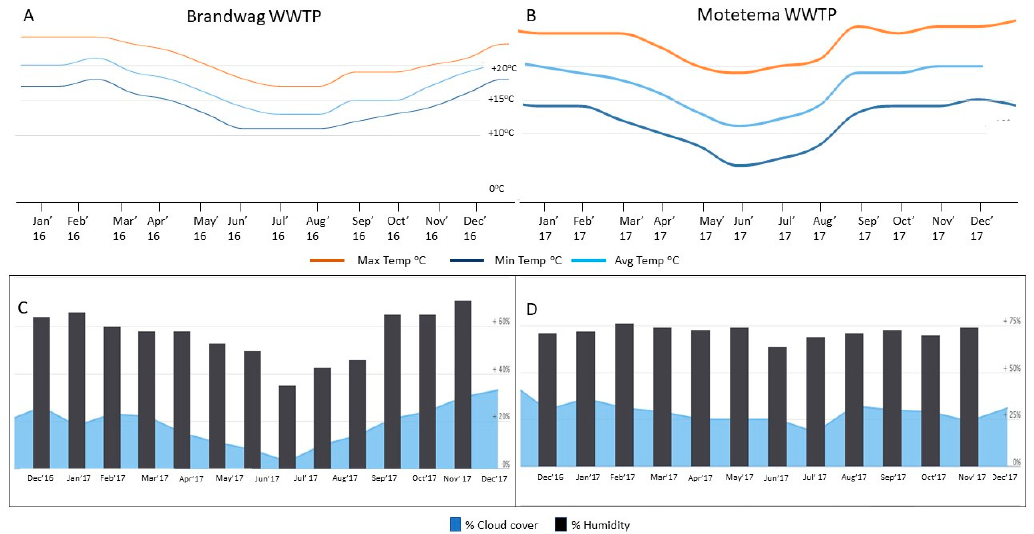
Figure 6. ( A ) Maximum, minimum, and average air temperature at the Brandwag municipality WWTP system during 2017. ( B ) Maximum, minimum, and average air temperature at the Motetema municipality WWTP system during 2016. ( C ) The percentages of cloud cover and humidity at the Brandwag municipality WWTP system in 2017. ( D ) The percentages of cloud cover and humidity at the Motetema municipality WWTP system in 2017.